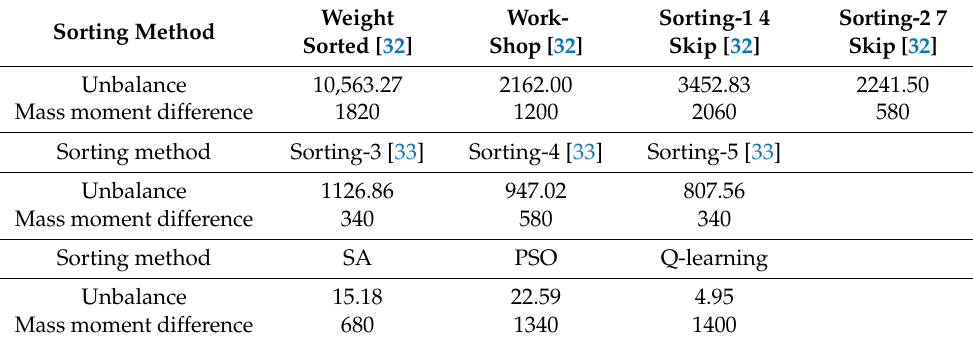
Table 5. Comparison of sorting method results.